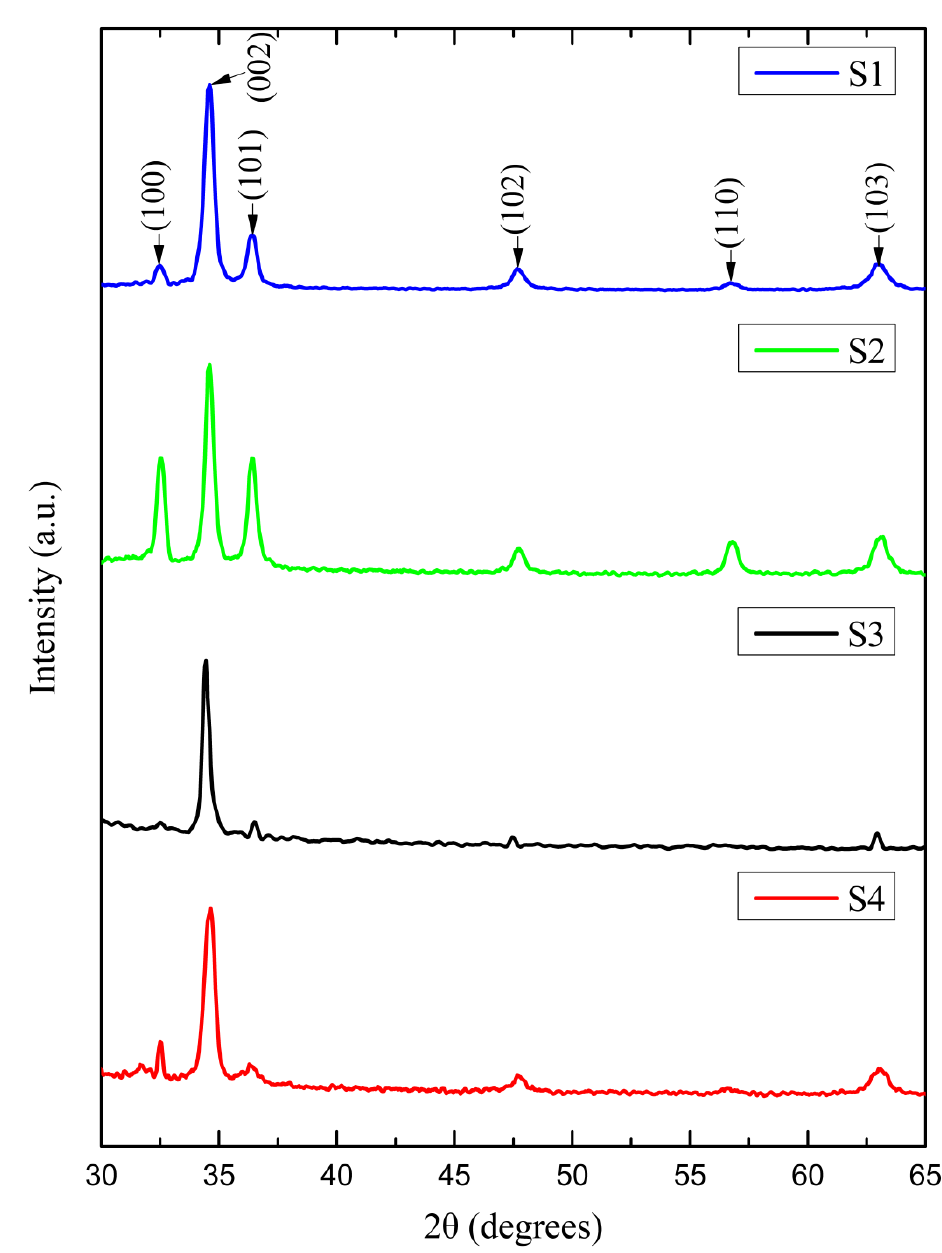
Figure 4. X-ray diffraction spectra of ZnO: F thin films deposited via ultrasonic spray Figure 4. X-Ray diffraction spectra of ZnO: F thin films deposited via ultrasonic spray pyrolysis.